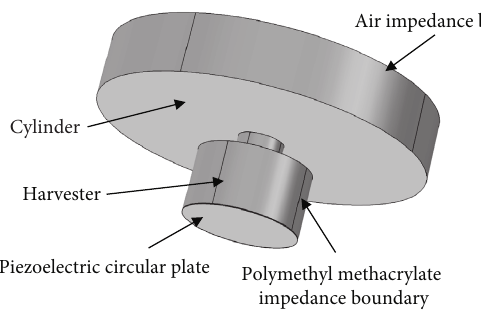
Figure 6: Geometry of finite element model of harvester.